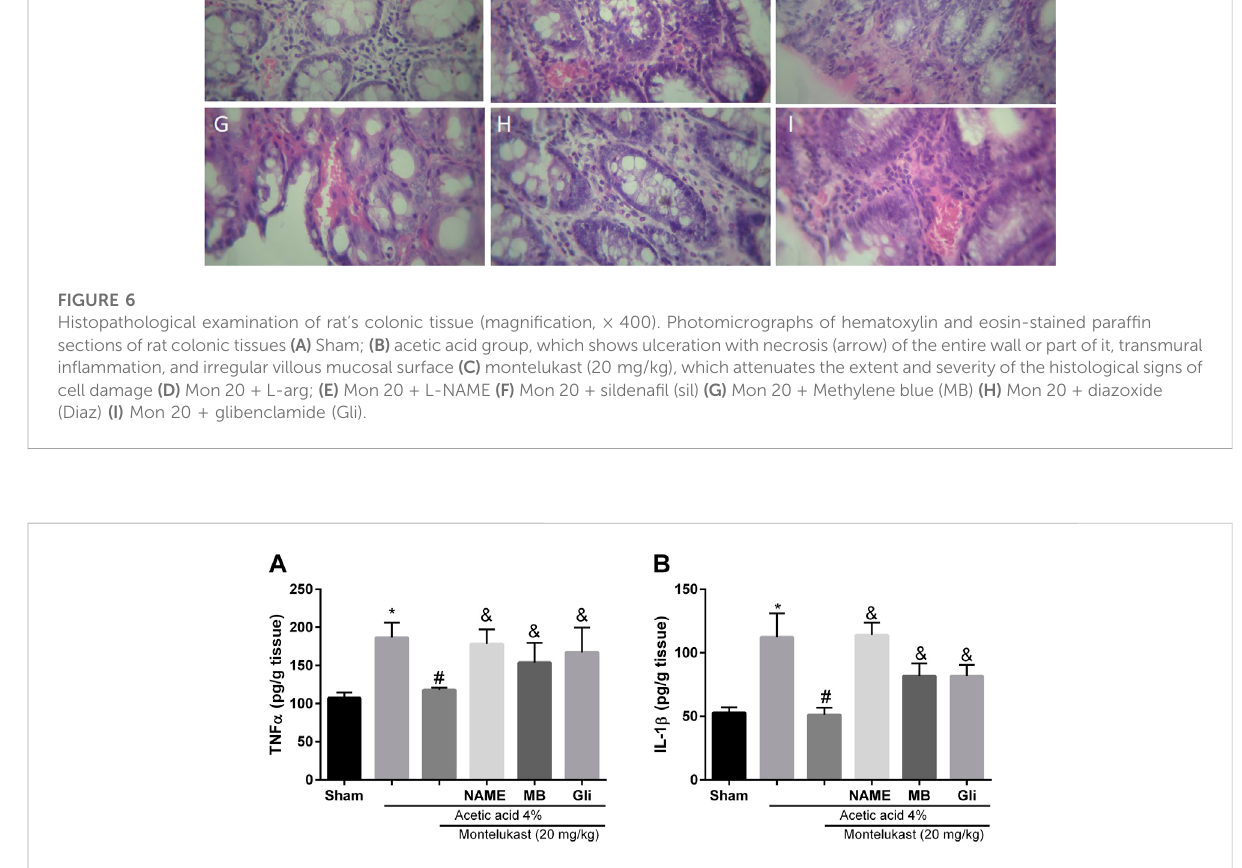
FIGURE 7 Montelukast (Mon) reduces TNF- α (A) and IL-1 β (B) levels in colon tissue. L-NAME, methylene blue (MB), and glibenclamide (Gli) restore the TNF- α and IL-1 β levels produced by Mon. * p < 0.05, when compared to the Sham group; # p < 0.05 when compared to the acetic acid group; & p < 0.05, when compared to the Mon-treated group. The statistical analysis was performed by ANOVA followed by Tukey ’ s post hoc